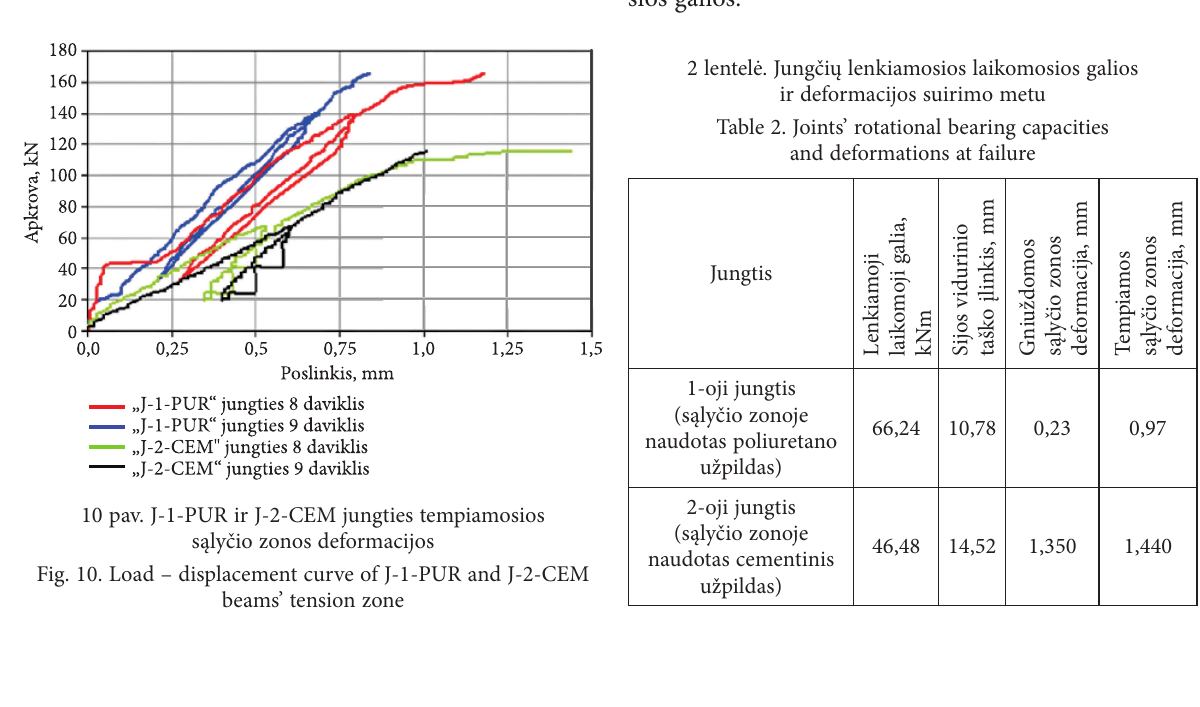
Fig. 9. Load – displacement curve of J-1-PUR and J-2-CEM beams’ compression zone